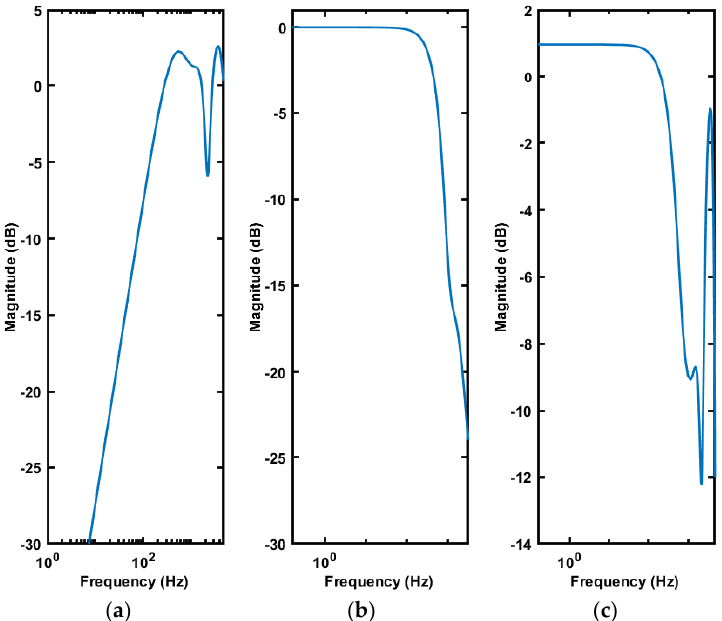
Figure 13. Closed loop sensitivity functions of the proposed RST control design: ( a ) output sensitivity function; ( b ) complementary sensitivity function; and ( c ) input sensitivity function. Table 4. Comparison of tracking control with PID-LSSVM approach on test data D, E, F, and G.